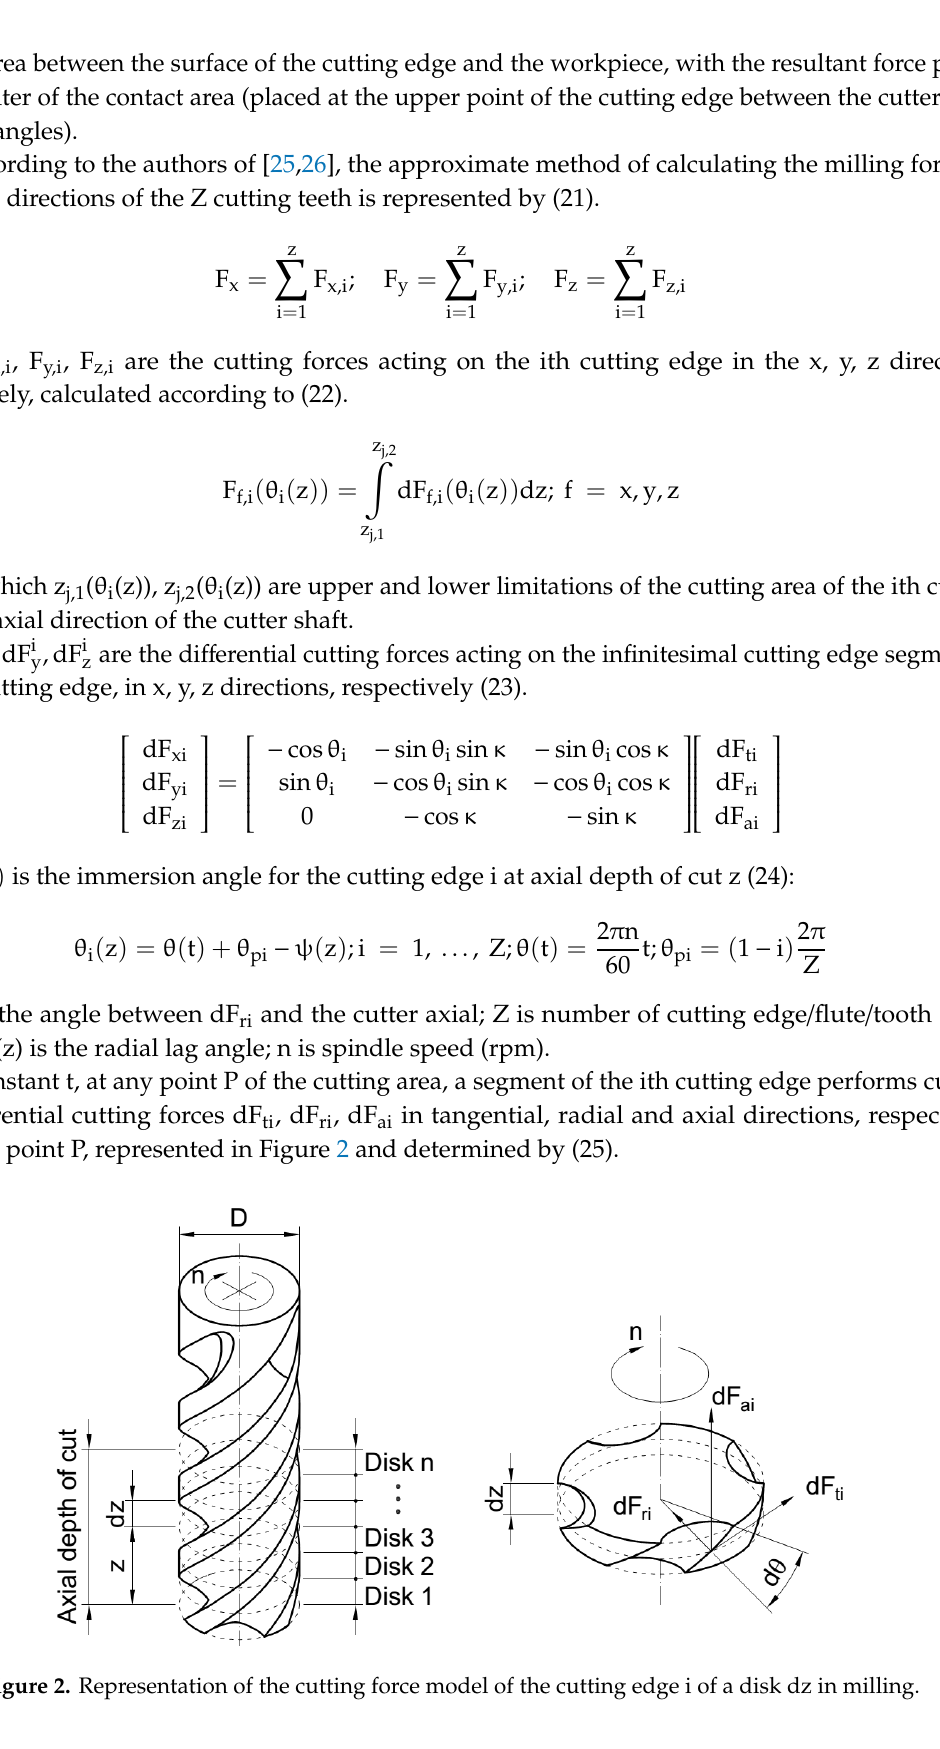
Figure 3. Scheme of the inverse dynamics method combined with the law of derivative proportional control (Inverse Dynamics + PD) controller in joint space 5. The Controller Based on Fuzzy Logic The literature on fuzzy control is very diversified, however for easy understanding this article briefly introduces fuzzy control. Some knowledge that is relevant and used in the paper is presented in Appendix A. Based on the contents presented in the Appendix A, it is easy to find out relevant issues when looking up references. Subsequent contents of the article with references (if any) in the Appendix A may help to clarify the fuzzy control base that is briefly presented below. This section presents the fuzzy controller design for a milling machining robot. The article uses the Mamdani fuzzy controller and selects the rule of Max-Min composition, the method of central defuzzification and triangular membership functions. The following shows the steps to design a fuzzy controller and propose fuzzy rules for the robot controller ( See also Appendix B). 5.1. Select the input, output signals and physical value domains 5.1.1. Select input and output signals Inputs are joint position errors e(t) and joint velocity errors e(t) over time of the robot system. Outputs are the adjustment amounts of the joint driving forces/torques u(t) at each machining instant to ensure that the errors e(t), e(t) are as small as the requirement of machining accuracy. u is the vector of the adjustment amounts of joint forces/torques of the robot and platform, which is calculated according to Formula (34),